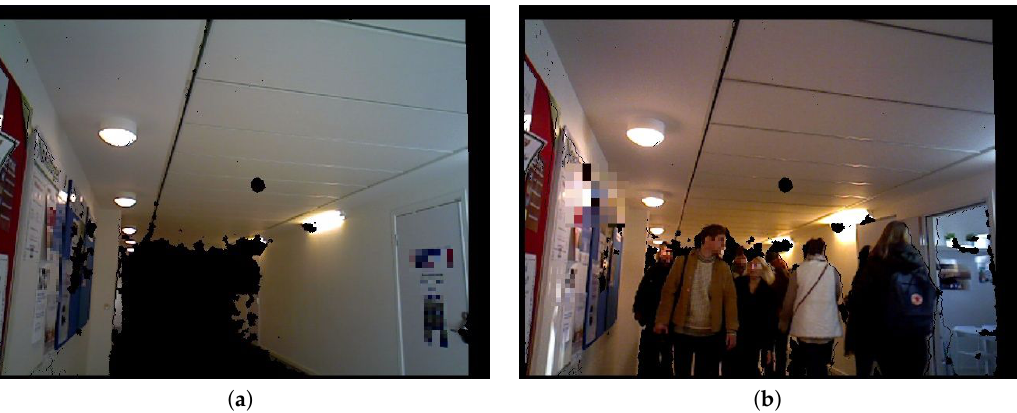
Figure 6. Sample images from distance data collection using the camera (Xtion Pro sensor). The faces of the people are blurred. ( a ) The corridor ( b ) People passing by the camera.